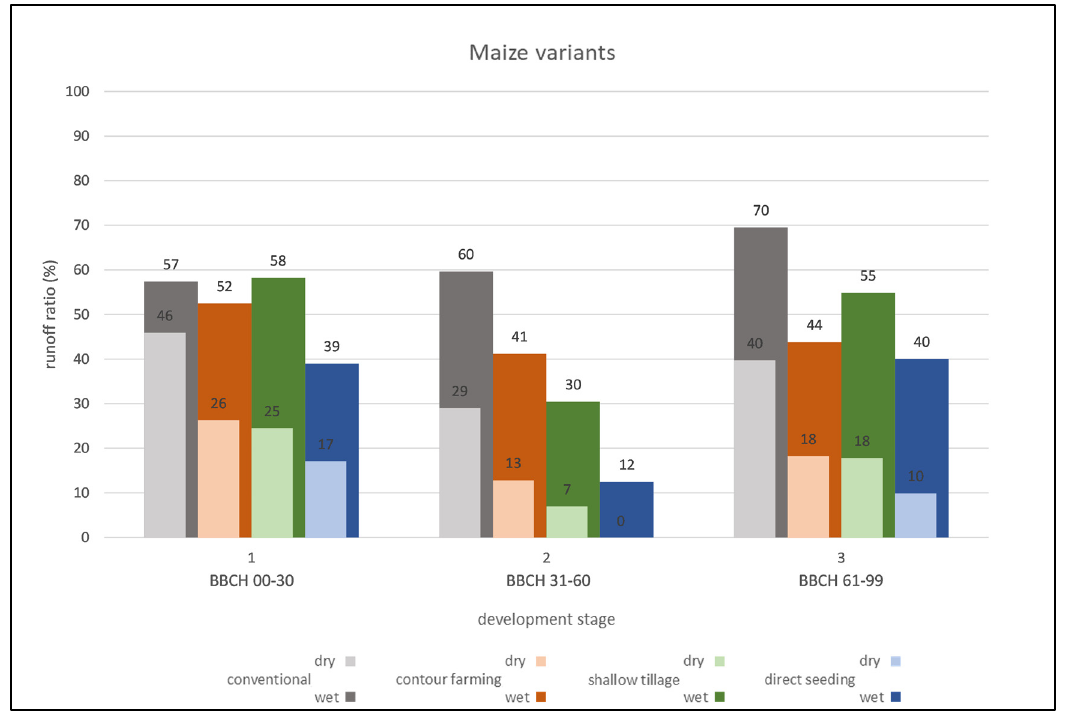
Figure 6. Runoff ratio of maize variants.